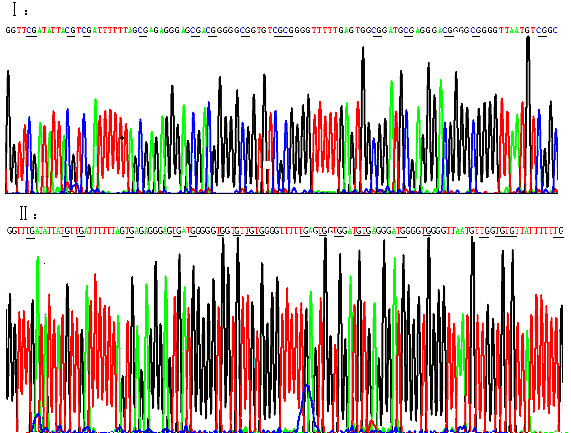
The sequencing results of MSP products in one patient with CML. I: The sequencing result of methylated product, CG was not changed after bisulfite treatment; II: The sequencing result of unmethylated product, T was replaced by C after bisulfite treatment.